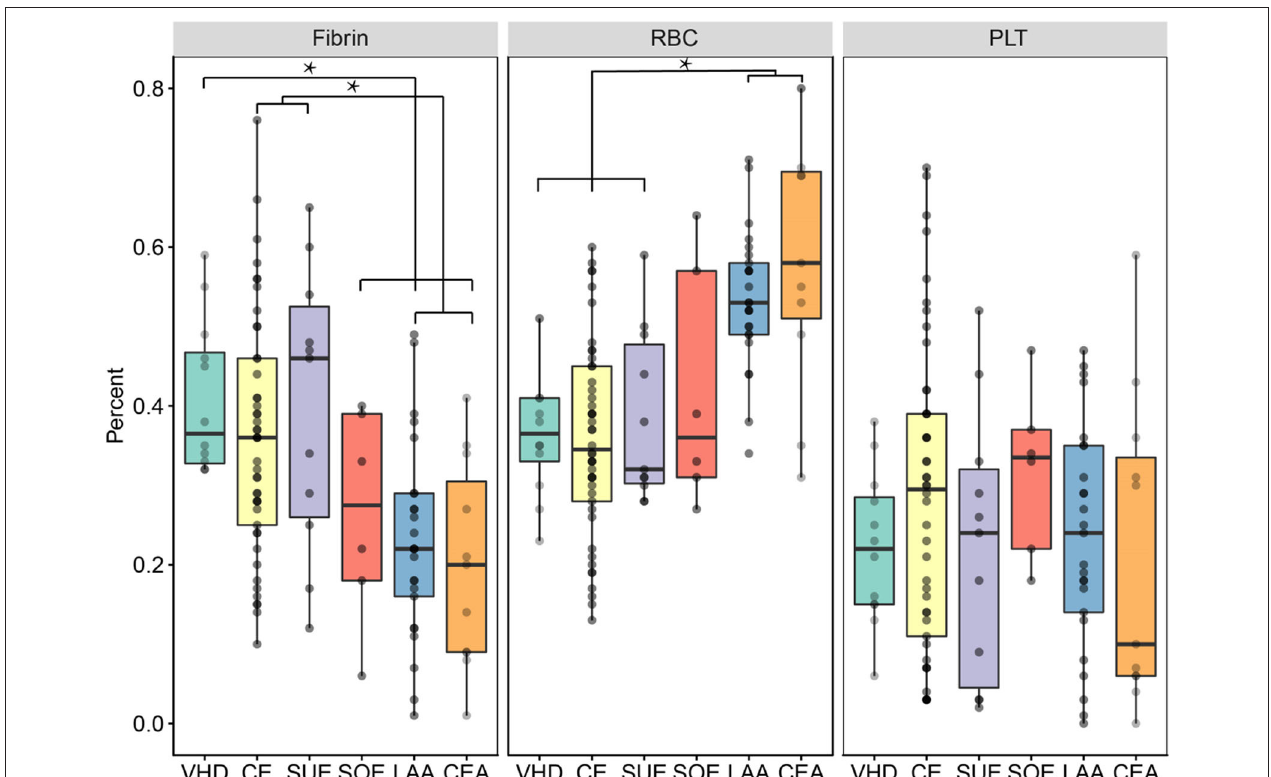
FIGURE 2 | Main sample components of VHD, CEA, and subtypes of TOAST. RBCs, red blood cells; PLT, platelets; VHD, valvular heart disease; CE, cardioembolic; SUE, stroke of undetermined etiology; SOE, stroke of other determined etiology; LAA, large artery atherosclerosis; CEA, carotid endarterectomy. * P <